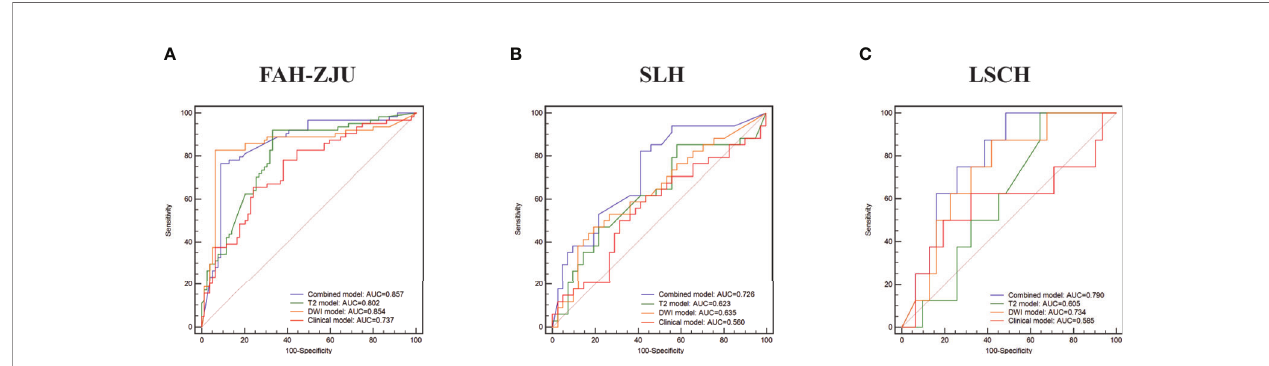
FIGURE 3 | The comparison of diagnostic performance of the radiomics classi fi ers and clinical classi fi er in the training cohort [ (A) First Af fi liated Hospital of Zhejiang University School of Medicine (FAH-ZJU)] and independent validation cohorts [ (B) Shulan Health (Hangzhou) Hospital (SLH); (C) Lishui Central Hospital (LSCH)]. The performance was measured by the area under the receiver operating characteristic (AUROC) curve. The radiomics classi fi ers consisted of the combined classi fi er (purple line), the T2 classi fi er (green line), and the diffusion-weighted imaging (DWI) classi fi er (orange line). The clinical classi fi er was shown as the